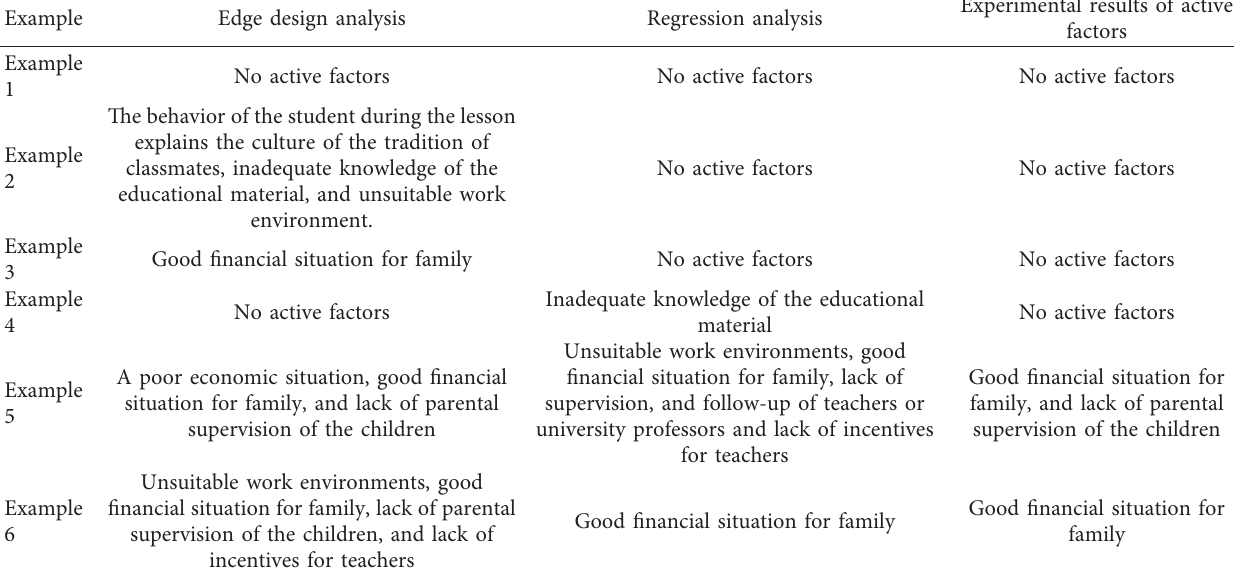
Table 21: Experimental results with two